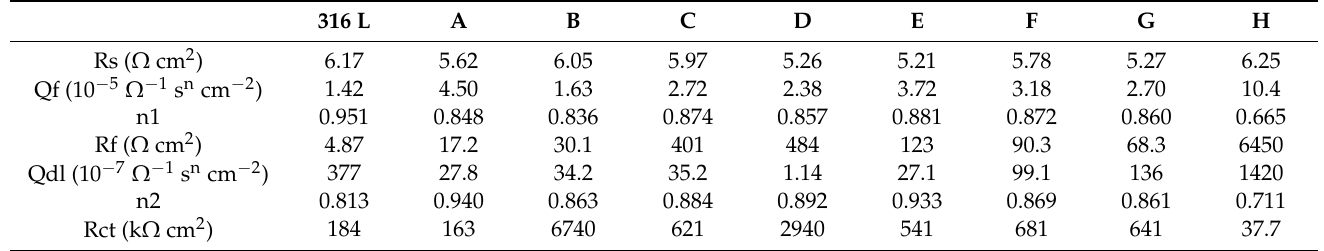
Table 4. Results of the fitting of equivalent electrical circuit conducted using the ZSimpWin software.